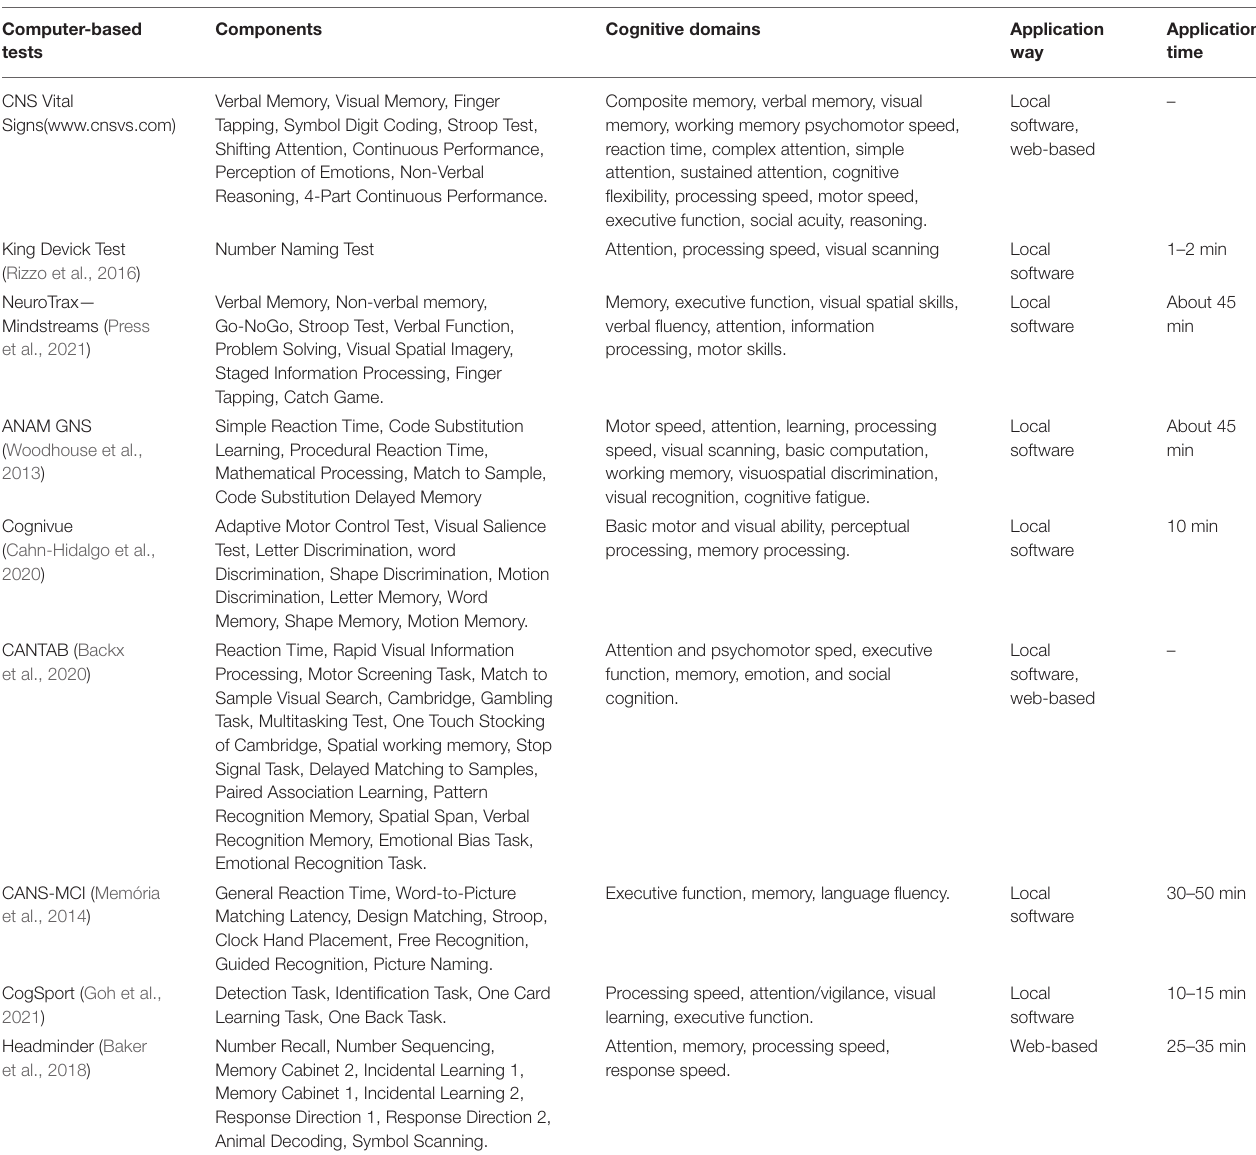
TABLE 2 | Computer-based